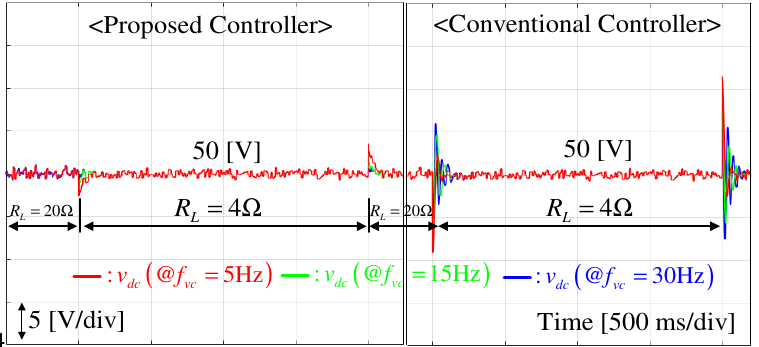
Figure 10. Output voltage control performance comparison at f vc = 5, 15, and 30 Hz, and constant reference regulation mode of v dc , ref = 50 V.